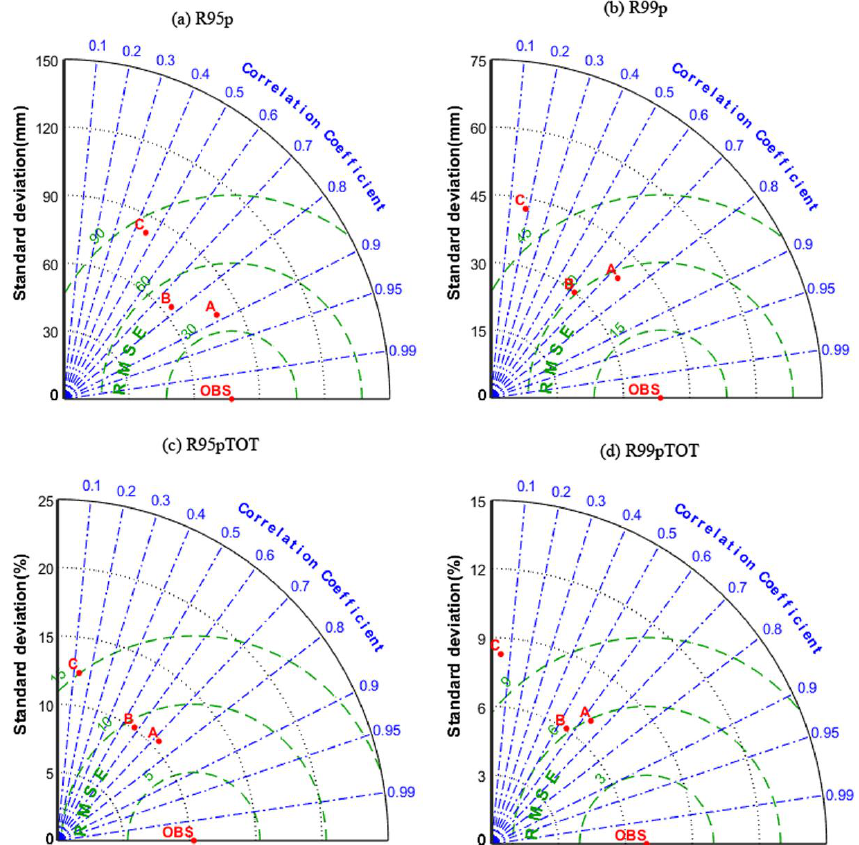
Figure 9. Taylor diagrams indicating correlation coefficients, standard deviation, and RMSE of R95p, R99p, R95pTOT, and R99pTOT indices from 1981 to 2014. ( A ) CMFD, ( B ) APHRODITE, and ( C ) CHIRPS. The radial coordinate (y axis) represents the magnitude of standard deviation, concentric semicircles represent RMSE, and the angular coordinate represents the correlation coefficient.